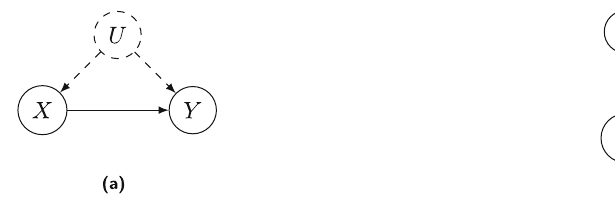
Figure 10: SCM associated with Example 5.2 with treatment X , recovery Y , UC U , and intent I . ( a ) Observational model. ( b ) The same system, but with intent explicitly modeled.